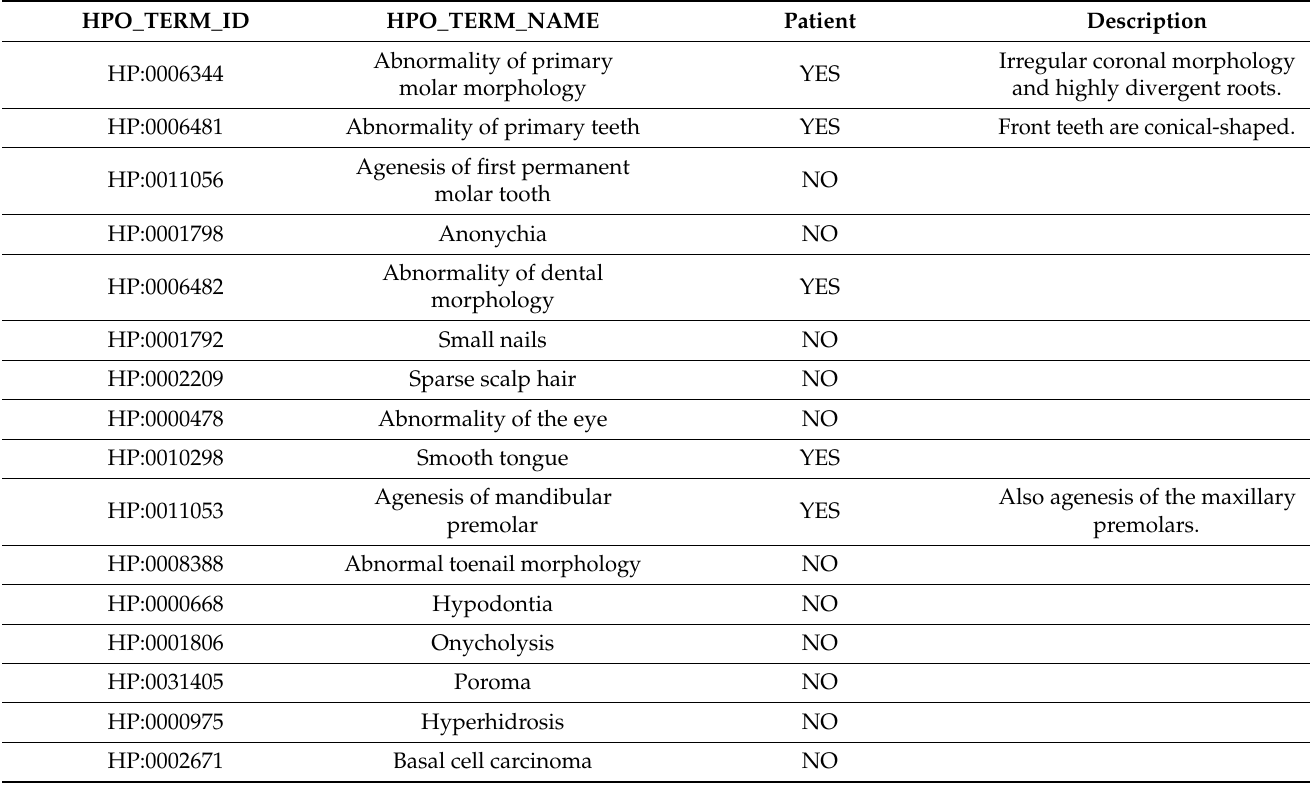
Table 1. Comprehensive phenotypic description of the patient based on the WNT10A gene using Human Phenotype Ontology